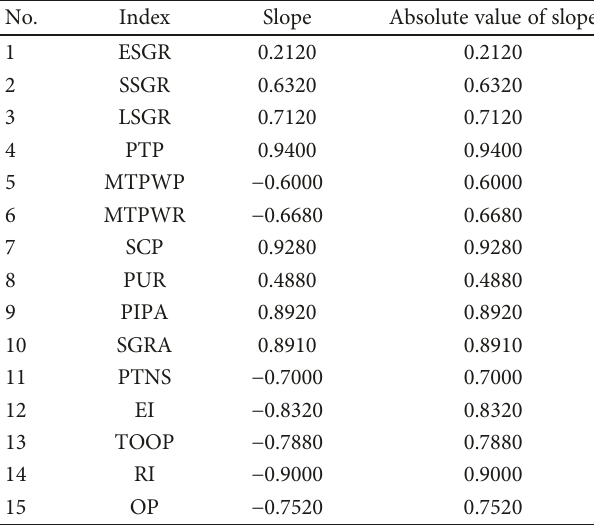
Table 9: The slopes of 15